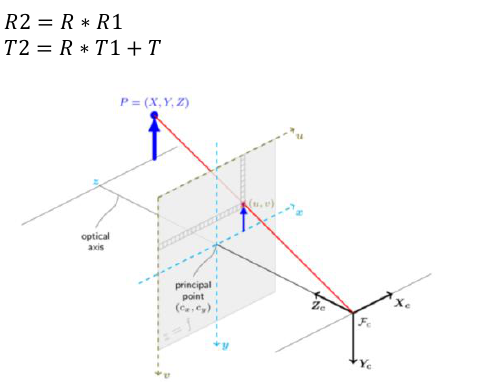
Figure 2: The pinhole camera